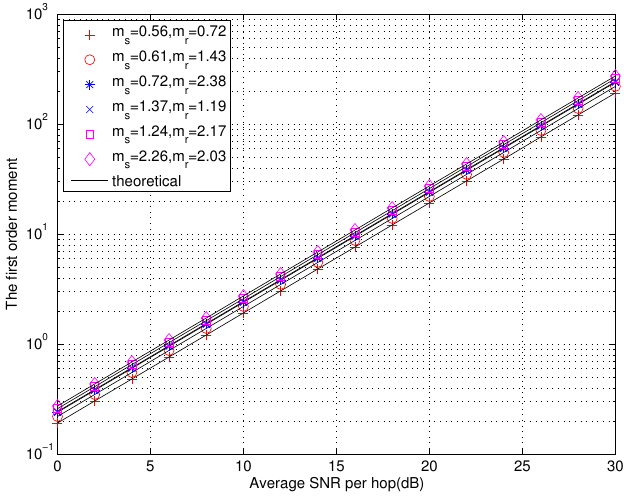
Figure 3. Comparison of the average SNR.